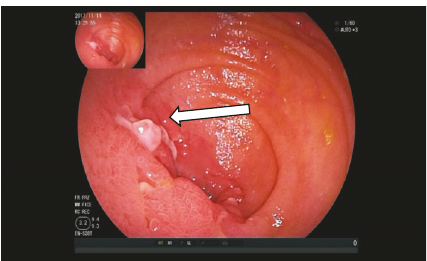
Figure 8: Enteroscopy showing a 3.0 x 2.0 cm size jejunal ulcer.